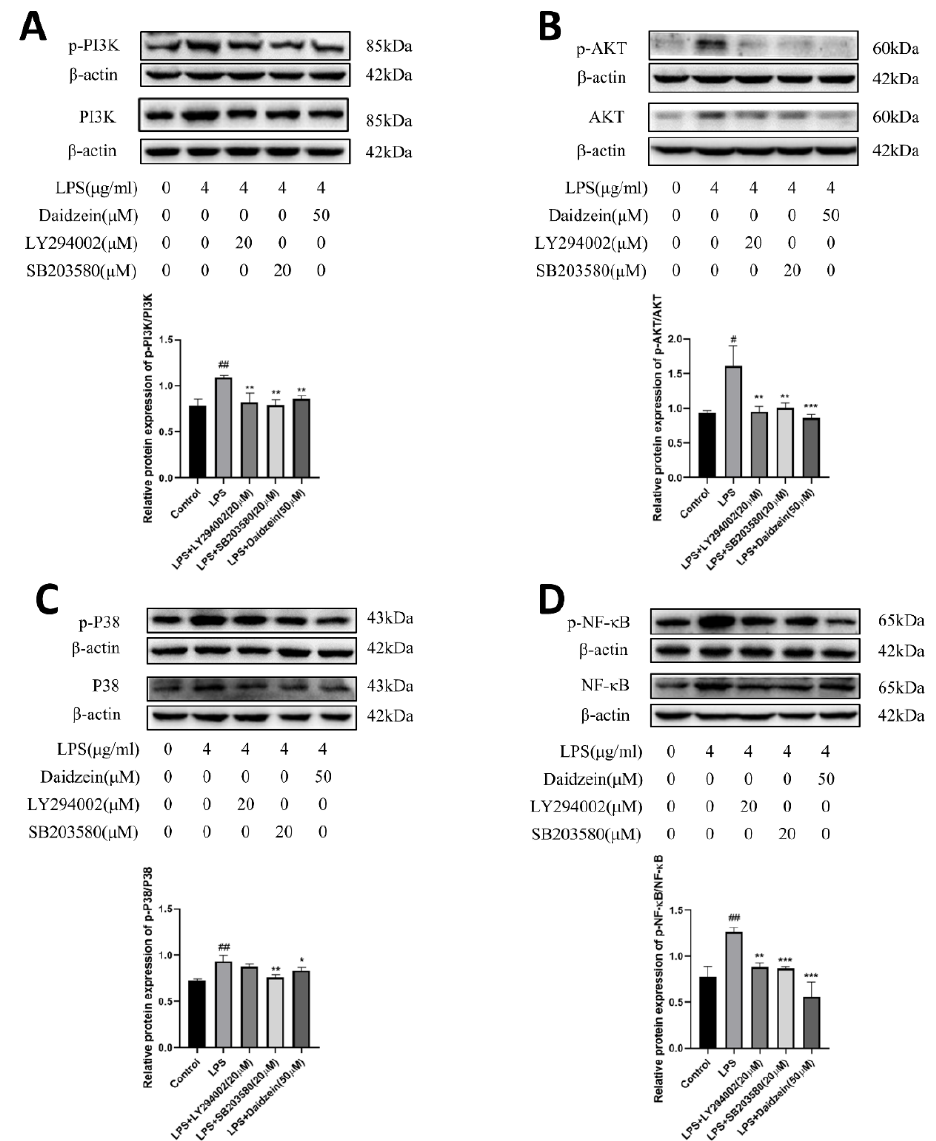
Figure 6. Daidzein suppressed the LPS-induced effects through the PI3K/AKT and P38 pathways. ( A , B ) The protein expression levels of the PI3K/AKT pathways. ( C ) The protein expression levels of the P38 pathway. ( D ) The protein expression levels of p-NF- κ B and NF- κ B (mean ± SD, n = 3), * p < 0.05, ** p < 0.01, and *** p < 0.001 versus LPS-treated alone. # p < 0.05, and ## p < 0.01 versus